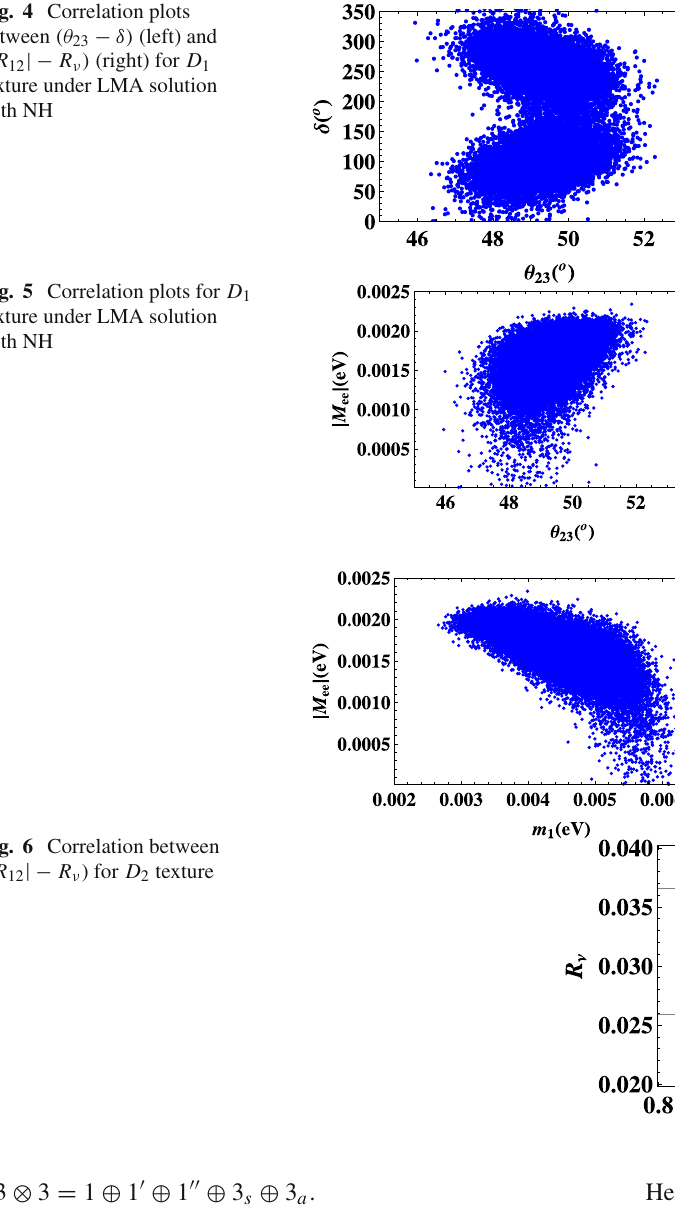
Fig. 4 Correlation plots between (θ 23 − δ) (left) and | − R ν ) (right) for D ( | R 12 texture under LMA solution with NH